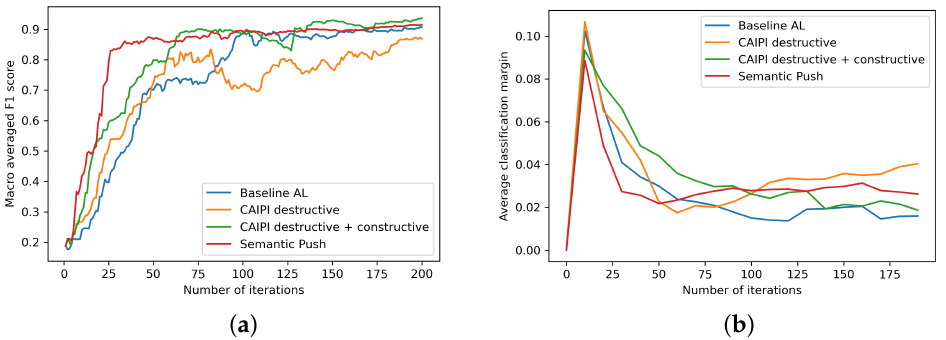
Figure 7. ( a ): Learning performance of different IML strategies for Reuters R10 Dataset (SVM as base learner). ( b ): Average Classification Margin of different IML strategies for Reuters R10 Dataset (SVM as base